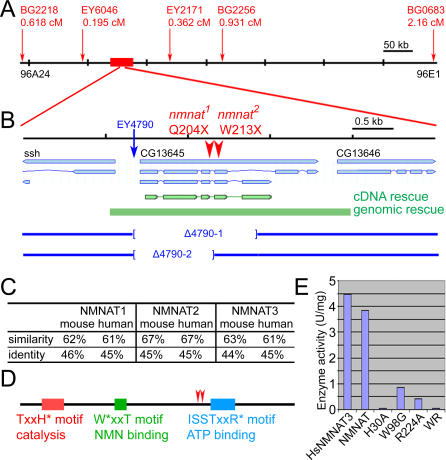
Complementation Group 3R4 Encodes nmnat, an Adenylyltransferase(A) Fine mapping using the P element recombination method. The insertion sites of the five P elements used to map the gene are marked by red arrows. The recombination ratio for each P element is listed in centiMorgans (cM). The red box marks the region delineated by fine mapping.(B) The genomic region of CG13645. The point mutations uncovered by sequencing are marked by red arrowheads. The genomic rescue construct and the cDNA rescue construct are both marked in green. The blue arrow indicates the insertion site of P element EY4790 used to generate the excision lines Δ4790–1 and -2. The boundaries of the excised regions are marked by brackets in the blue lines.(C) Drosophila NMNAT protein is homologous to mouse and human NMNAT1, −2, and −3. Percentages of similarity and identity to each mouse and human protein are listed.(D) The organization of the NMN adenylyltransferase activity center. The key amino acids mutated to reduce enzymatic activity are marked by asterisks (*). The amino acid positions of the nonsense mutations in both alleles are marked by red arrowheads.(E) The Drosophila NMNAT protein has similar enzymatic activity as human NMNAT3. The activity is measured by the continuous coupling assay and listed in units per milligram of recombinant protein. The mutant proteins H30A, W98G, R224A, and WR (W98G/R224A double mutant) have 1.4%, 22%, 10.8%, and 0.9% of the activity of wild-type protein, respectively.